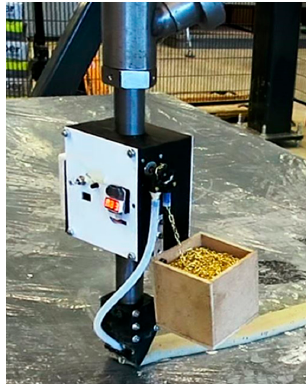
Figure 3. Early version of RED, equipped with chain reinforcement. Table 1. Cables used as reinforcement.